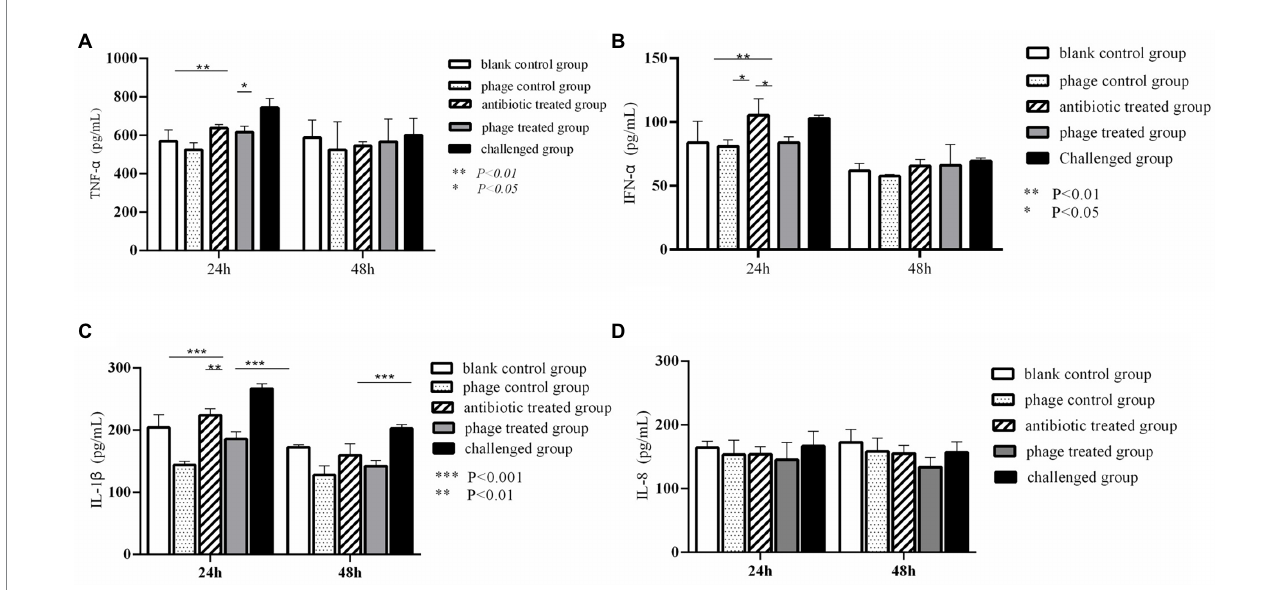
FIGURE 4 Dynamic change of cytokines in the animal experiment. Levels of TNF- α in different group. **P < 0.01, *P < 0.05 (A) ; Levels of IFN- α in different group. ** p < 0.01, * p < 0.05 (B) ; Levels of IL-1 β in different group. **p < 0.01, ***P < 0.001 (C) ; Levels of IL-8 in different group (D) .